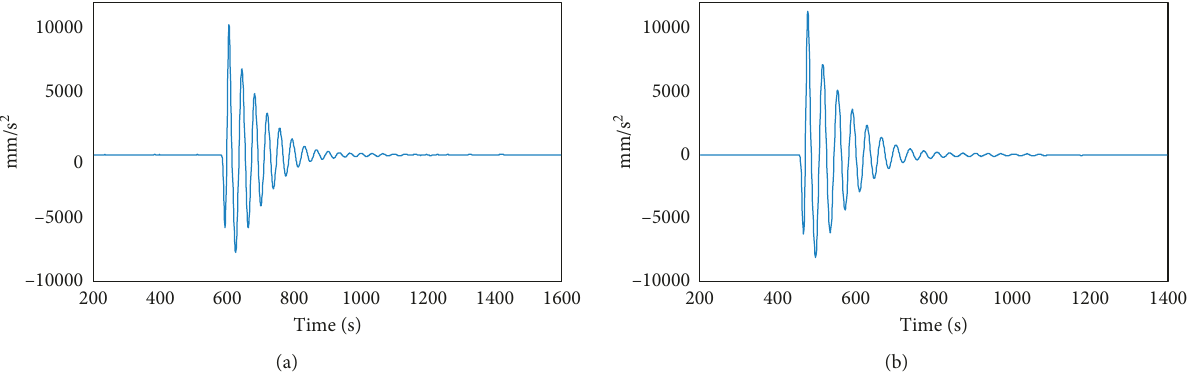
Figure 14: Signal amplitude of the beam vibration.